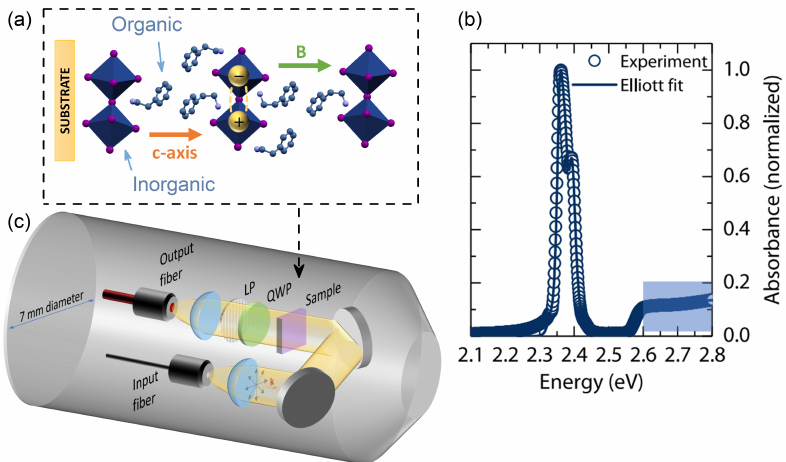
Figure 1. ( a ) Structure of 2D (PEA) 2 PbI 4 layered perovskite. Arrows indicate the direction of the magnetic field vector B and c -axis vector with respect to the substrate and inorganic planes (Faraday geometry). ( b ) Low-temperature absorption spectrum of (PEA) 2 PbI 4 . Reprinted with permission from Neutzner et al. [43]. Copyright 2022 by the American Physical Society. ( c ) Schematic drawing of the high magnetic field inset tip. QWP—quarter-wave plate, LP—linear polarizer, k —wave vector of the probing